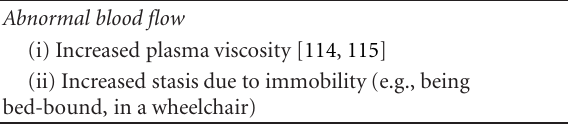
Table 1: Virchow’s triad in